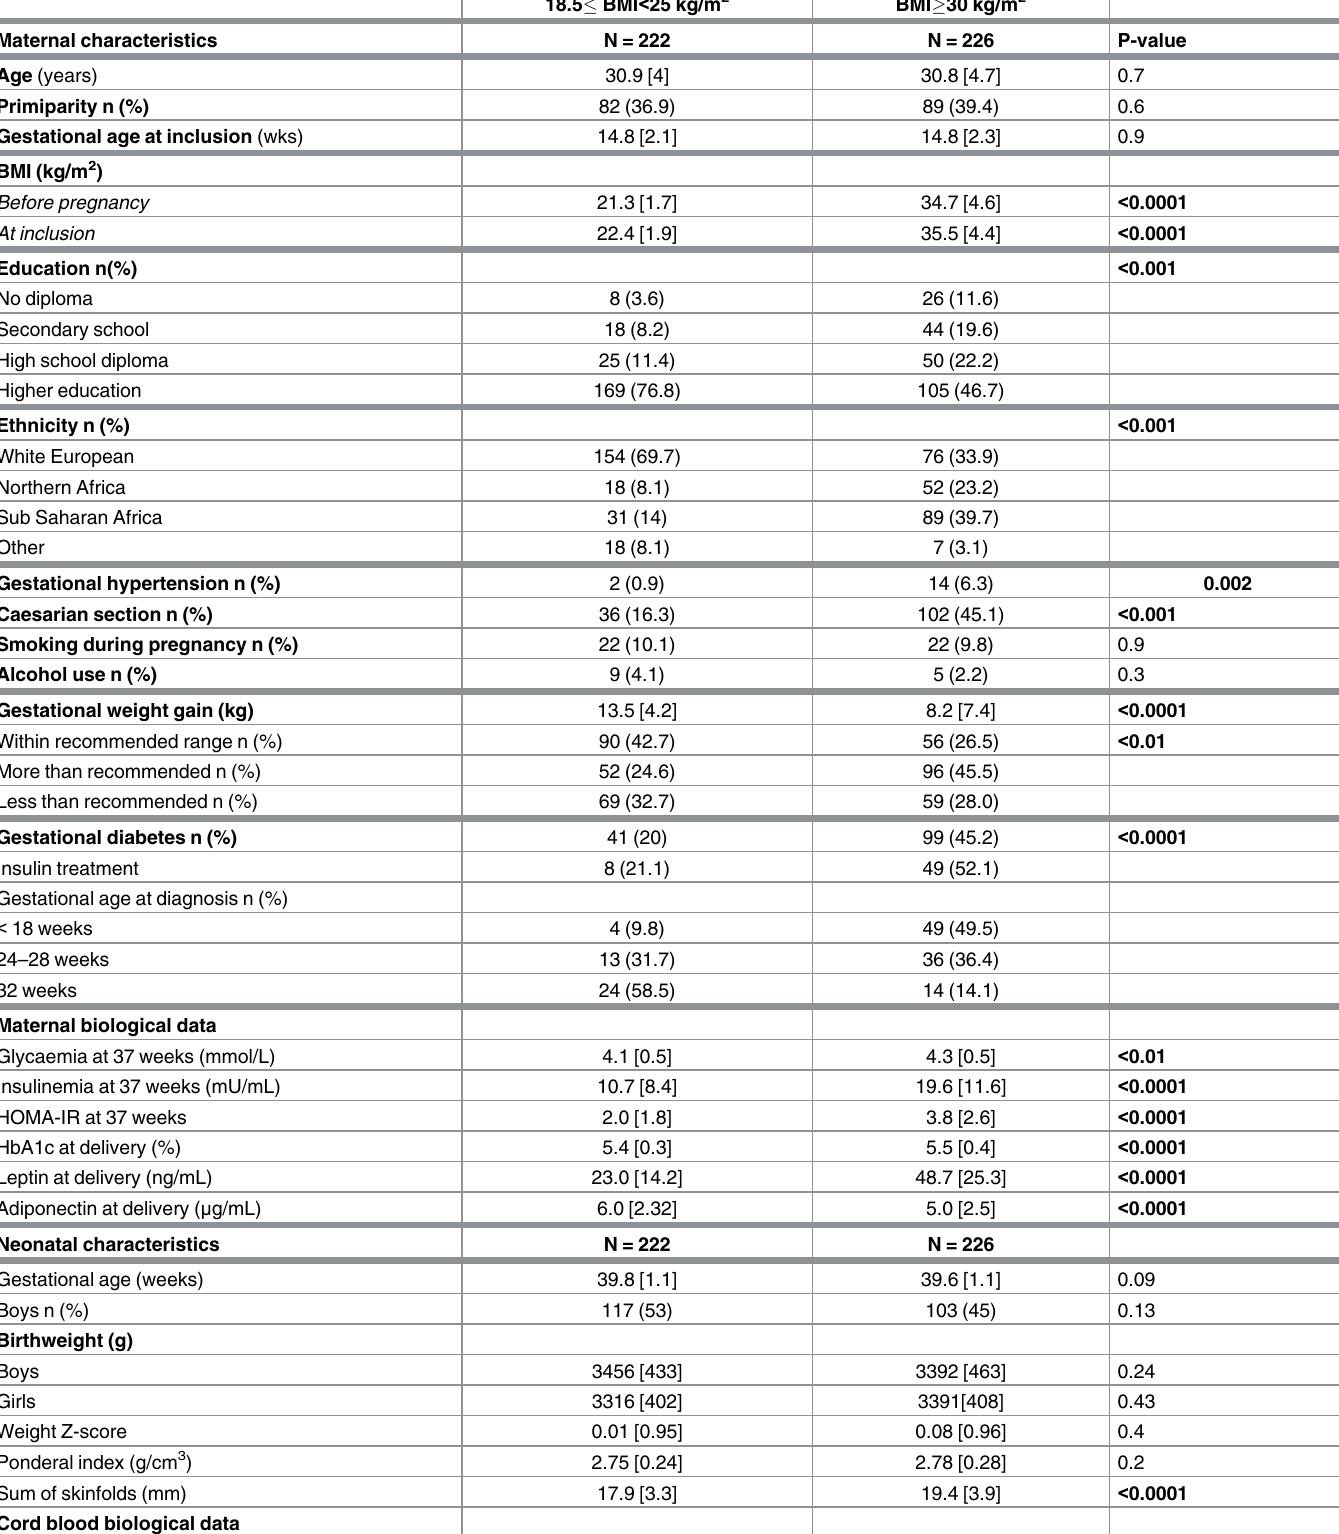
Table 1. Maternal and neonatal characteristics according to maternal BMI. Data are expressedas mean [SD] or N